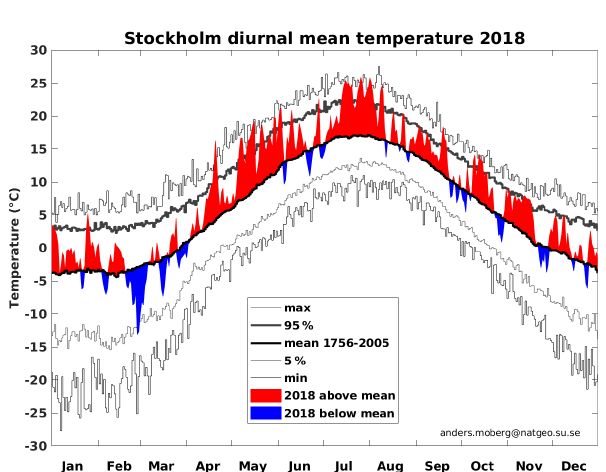
Figure 1. Diurnal mean temperatures in Stockholm in 2018. For each day, the anomaly with respect to the 250-year climatological mean for 1756–2005 is displayed in red (warm) or blue (cold). The diagram also shows the warmest and coldest diurnal mean tempera- ture for each calendar day recorded within the 1756–2005 period as well as the corresponding 5th and 95th